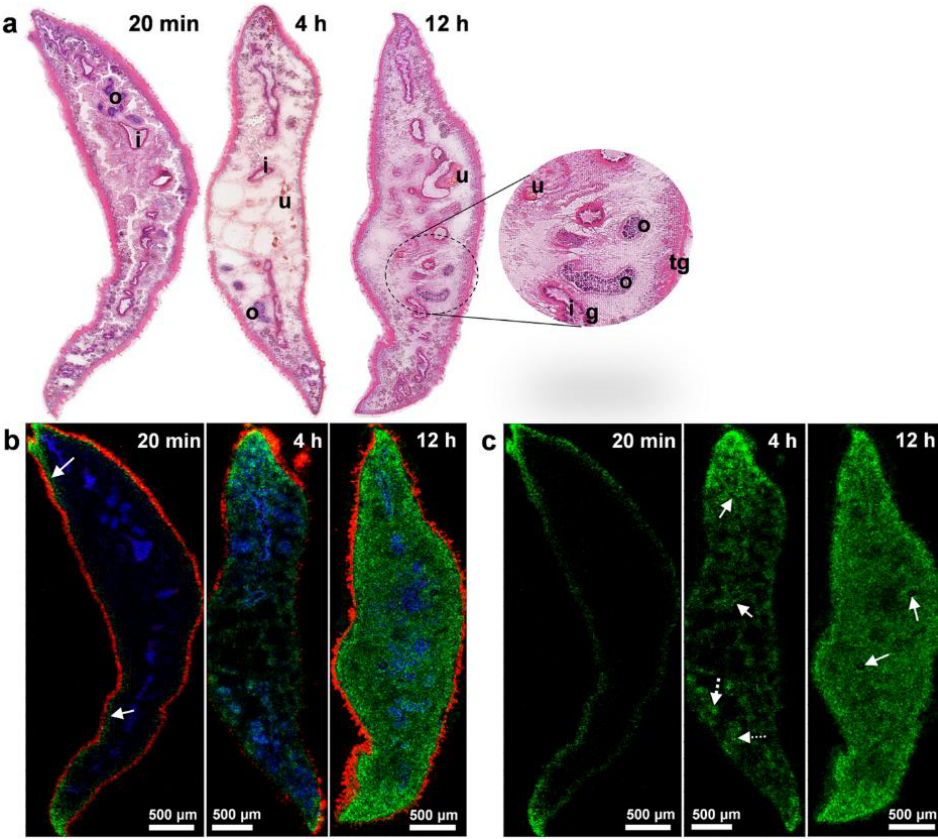
Figure 6. Kinetic of triclabendazole (TCBZ) uptake and distribution in Fasciola hepatica . Figure was reproduced from Morawietz and colleagues’ work [102].